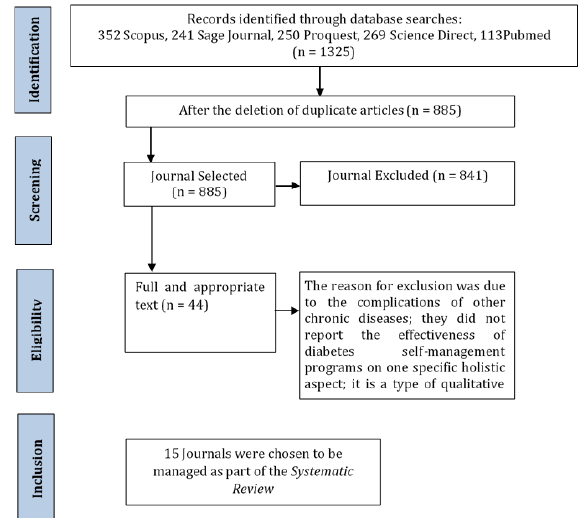
Figure 1. Literature search